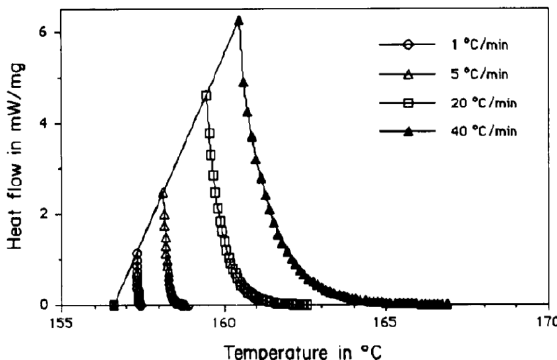
Figure 9. The effect of heating rate on peak shape for indium, after [61].